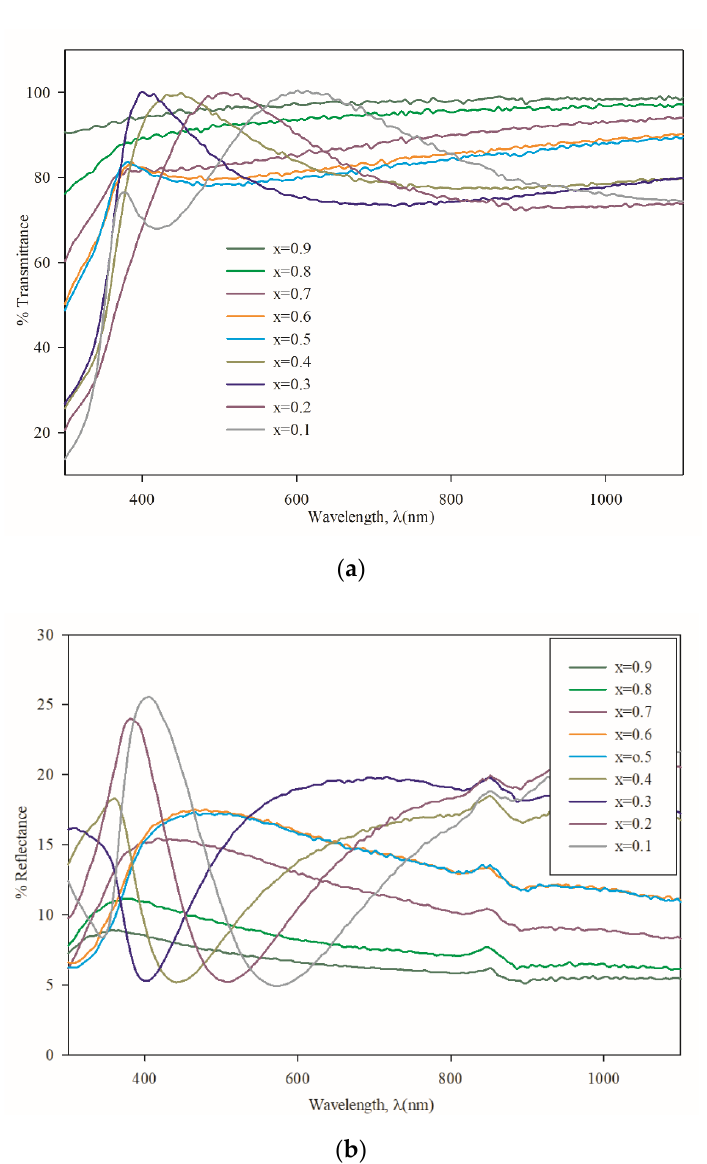
Figure 6. ( a ) Transmittance vs. wavelength plots; ( b ) Reflectance vs. wavelength plots.